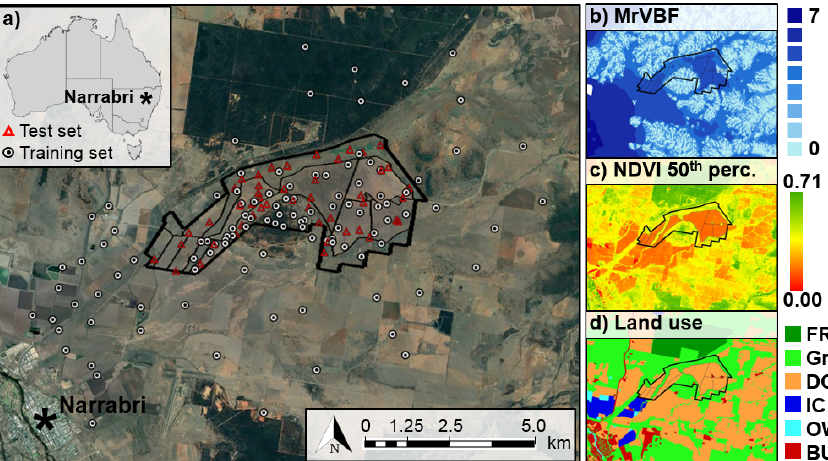
Figure 1. (a) Location of L’lara farm and the wider study area in relation to the township of Narrabri, NSW, Australia. Sample locations used as a training set ( n = 108) and test set ( n = 50) are indicated. Satellite imagery sourced from Google Earth Pro V 7.3.2.5776 (5 March 2019). Narrabri, NSW, Australia. 30 ◦ 16 (cid:48) 31.37 (cid:48)(cid:48) S, 149 ◦ 51 (cid:48) 46.42 (cid:48)(cid:48) E. Eye altitude: 20.57km. Image © CNES/Airbus 2020 (http://www.earth.google. com, last access: 20 April 2020). (b) MrVBF calculated at 30m resolution using the SRTM digital elevation model. (c) Pixel-wise 50th percentile of NDVI calculated from Landsat 7 scenes covering the time period 2000 to 2018. (d) Simplified land use across the study area (ABARES, 2018). FR: forest reserve; Gr: grazing including understorey grazing and stock routes; DC: dryland cropping; IC: irrigated cropping; OW: open water; BU: built-up areas. The external perimeter boundary of L’lara is indicated by the thick black line, and boundaries of cropping paddocks are indicated by thin black lines. Table 1. Summary of sampling campaigns and land use for each dataset. Observations ( n ) Sample set Location Forest